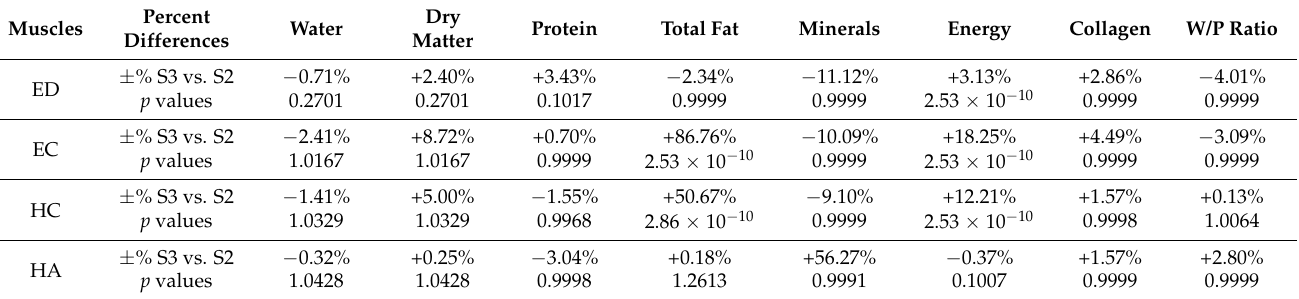
Table 6. Analysis of variance between ages (two summers vs. three summers) on the chemical composition and certain nutritional features of Polyodon spathula